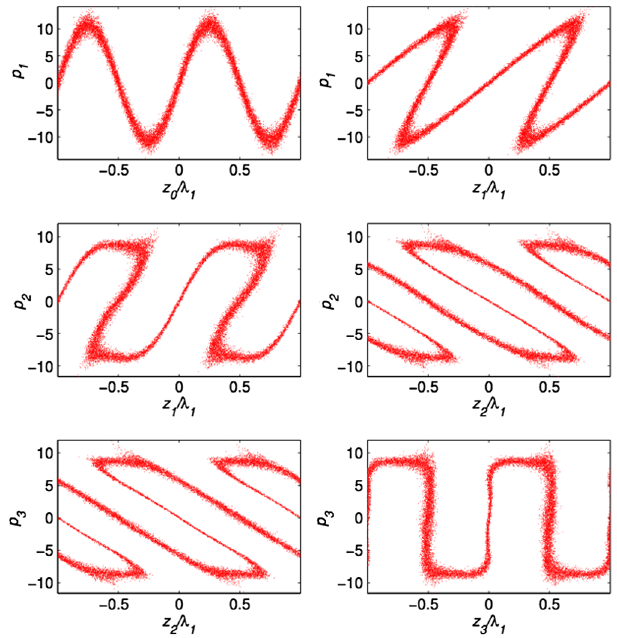
FIG. 6. Synthetic squarewavegeneration withthree modulations of wavelength (cid:6) 1 . Here A 1 ¼ 10 , A 2 ¼ A 1 = 4 , A 3 ¼ A 2 = 16 , B 1 ¼ ffiffiffi p 3 (cid:1)= 2 A 1 , B 2 ¼ (cid:1) 3 B 1 , B 3 ¼ (cid:1) 3 B 2 = 4 , (cid:3) 2 ¼ 0 , and (cid:3) 3 ¼ (cid:1) .